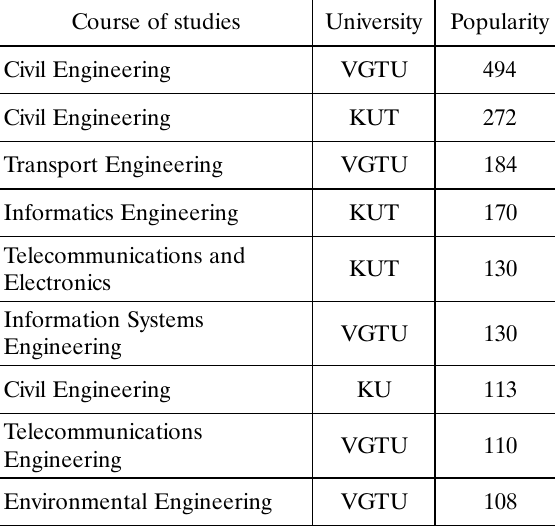
Table 2. The most popular courses of studies in technological sciences based on the courses ranked the first in the application